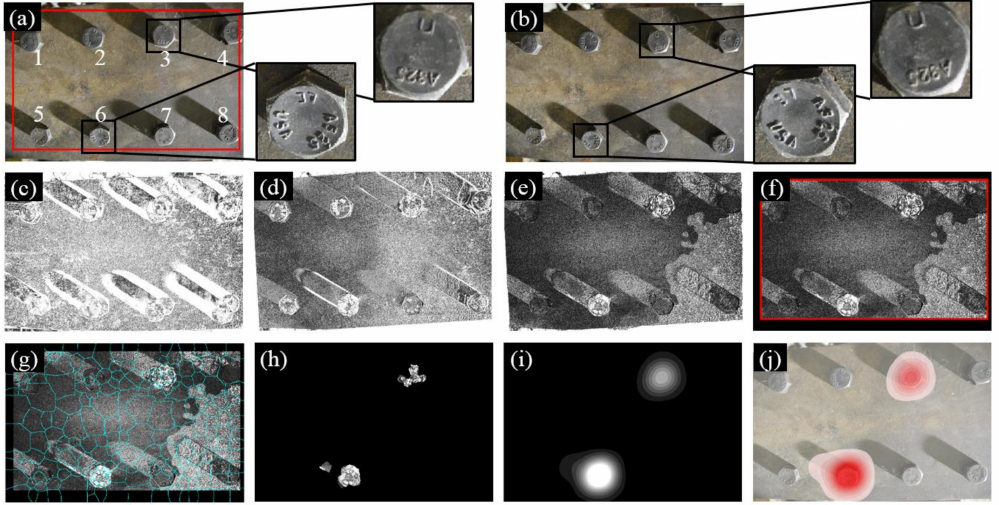
Figure 9. Experimental results of Test 2: ( a ) Image 1 taken at the first inspection period; ( b ) Image 2 taken at the second inspection period; ( c ) initial errors between Image 1 and 2; ( d ) errors after feature-based image registration; ( e ) errors after intensity-based image registration; ( f ) windowing applied to the registration errors; ( g ) registration errors segmented into superpixels; ( h ) feature enhancement; ( i ) Gaussian filtering; and ( j ) result implementation. The brightness of Figure 9c–h is enhanced for demonstration